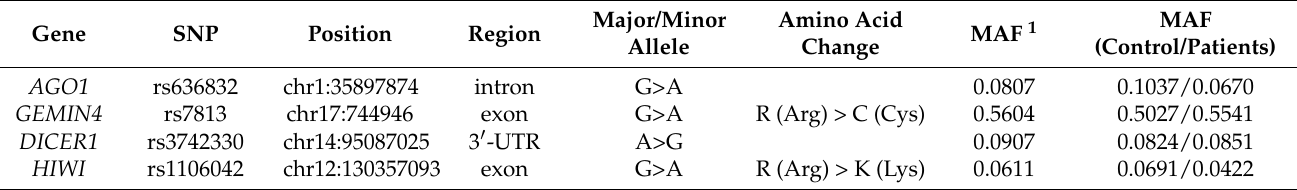
Table 2. General characteristics of the analyzed SNPs of miRNA processing